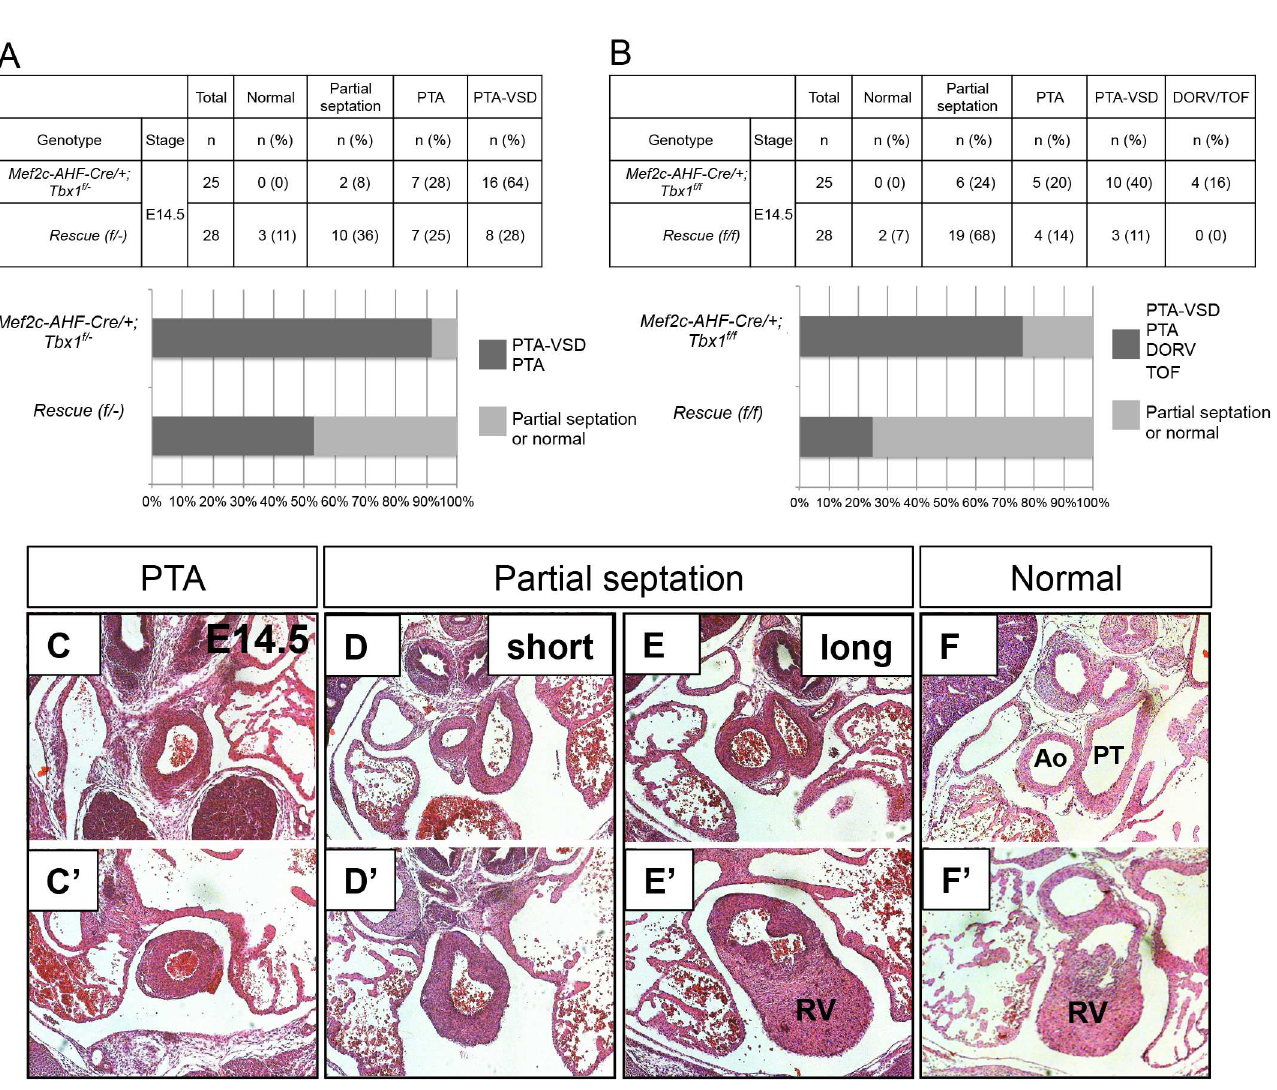
Fig 4. Phenotype analysis of significantly rescued Tbx1 LOF embryos. Phenotypes in embryos in which one β -catenin loss of function alleleto either Mef2c-AHF-Cre/+;Tbx1 f/- embryos (A) or to Mef2c-AHF-Cre/+;Tbx1 f/f embryos (B) was done to lower the dosage of β -catenin within the AHF. Significantrescue (p < 0.001, Fisher’s exact test) was obtainedin both sets of doublemutant embryos. Middle panelsshow the percent within the groups with PTA (C and C’), DORVor TOF associatedwith a VSD or PTA without VSD (dark grey) and those ones with partial septation or a normal heart (light grey). Partial septationin Tbx1 LOF embryosmeans a PTA with presenceof a short septum at some level of the OFT (D and D’) and completeseptationbetweenthe ventricles(8/50) while partial septationin the rescue genotypeembryos (34/56) means a range of noticeablyless severe phenotypesincluding:a longerpartial OFT septation(E and E’) and either completeseptationbetweenventricles(15/56) or VSD (10/56) or normal OFT (F and F’) with a VSD (4/56) or normalheart [5/56] (F and F’). Abbreviations: aorta (Ao), pulmonary trunk (PT), right ventricle(RV), outflow tract (OFT), PTA (persistent truncus